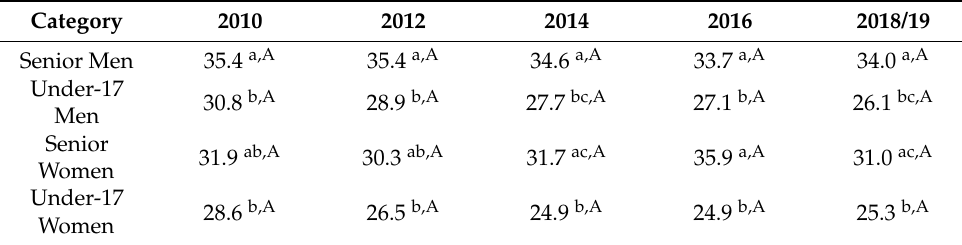
Table 5. Success rate of three-point shots